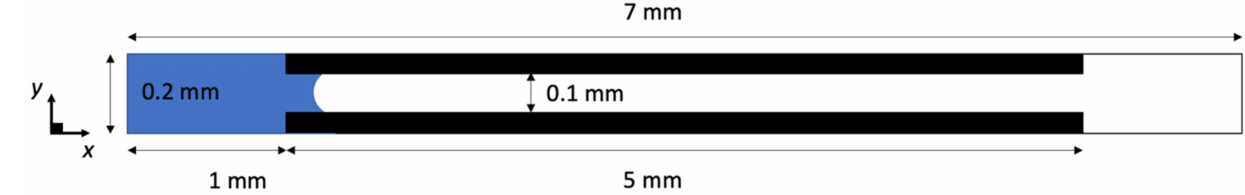
Figure 3. Simulation setup for capillary intrusion test of water (blue) into parallel